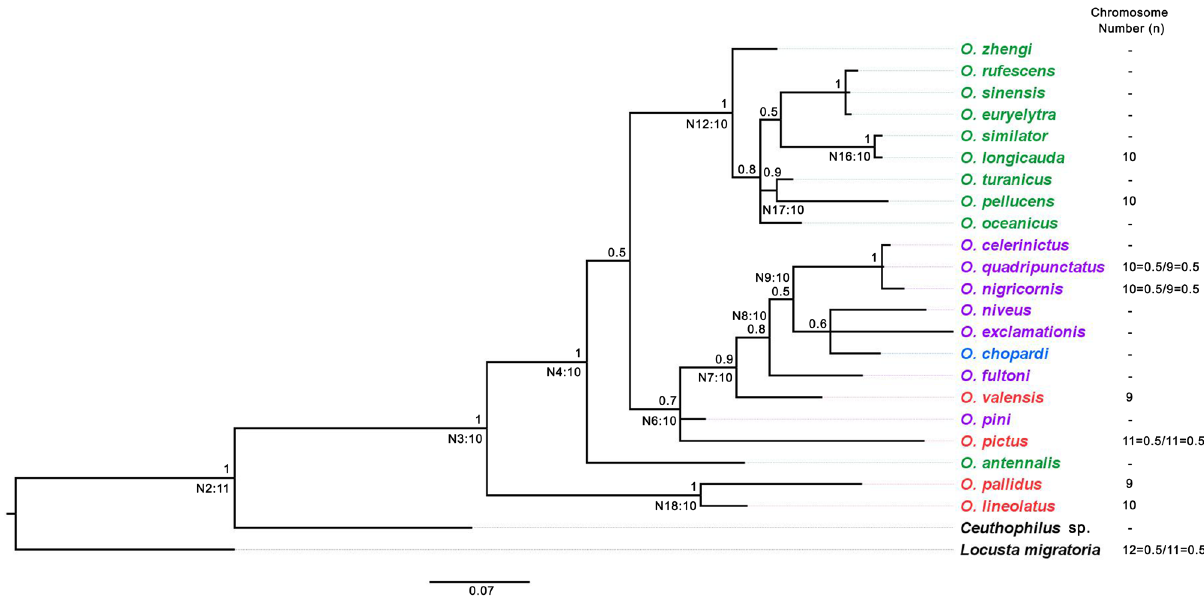
Figure 4 – Bayesian Inference using mitochondrial concatenated data (COI, 12S rDNA, and 16S rDNA) in Oecanthus species. Colors indicate each bioregion: green, species from the Palearctic bioregion; purple, Nearctic; red, Neotropical; and blue, Ethiopian. The outgroups were Ceuthophilus sp. and Locusta migratoria . Above each branch are indicated the posterior probabilities; (N) represents the node names and the ancestral haploid chromosome number inferred by ChromEvol software. Chromosome haploid number of living species, and (-) represents missing data for